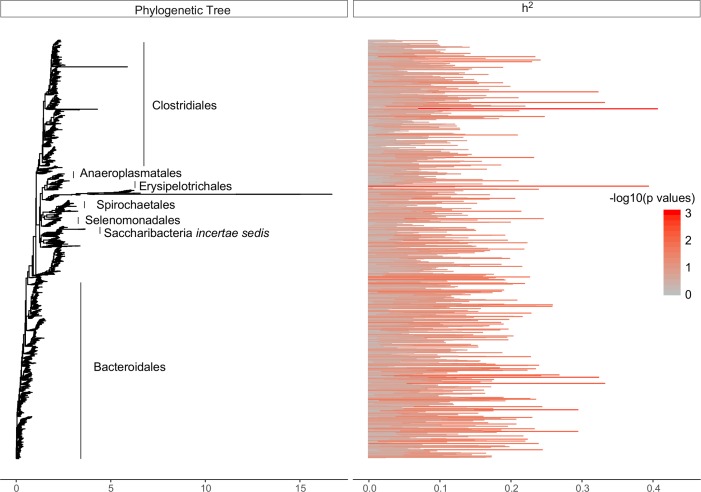
Phylogeny of 3,894 rumen bacterial OTU.Branch lengths represent substitution number per site calculated by FastTree2[81]. Heritability estimates (h2) for each OTU abundance are plotted with a horizontal bar and colored by taxonomic group classification.